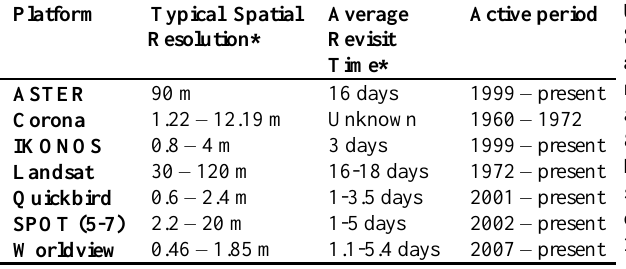
Table 1: Common satellite remote sensing platforms, their resolutions, average revisit times and years of